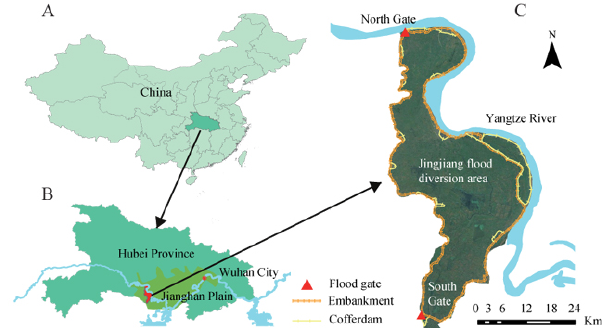
Fig. 6. Location of the study area: (A) map of China, in which the annotated area is Hubei province. (B) Map of Hubei, in which the annotated area is Jianghan Plain, Wuhan City, and the Jingjiang flood diversion area. (C) Map of the Jingjiang flood diversion